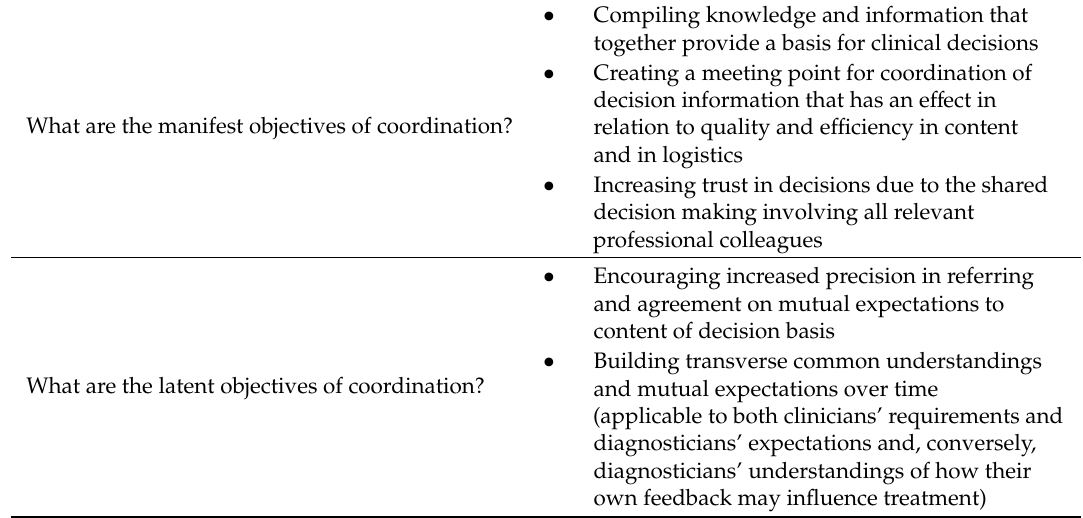
Table 11. Coordination in patient pathways via multi-disciplinary team (MDT) meetings.